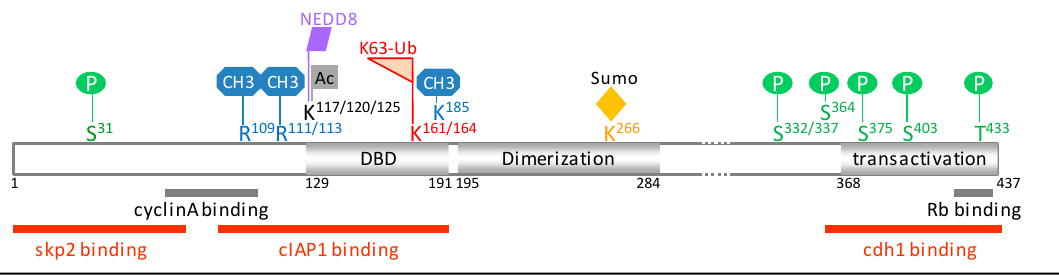
Figure 2. Schematic representation of E2F1 protein sequence (NP_005216.1). The regions interacting with cyclin A, Rb (retinoblastoma), and the E3-ubiquitine ligases skp2 (S-phase kinase-associated protein 2), cIAP1 (cellular inhibitor of apoptosis 1), and cdh1 are shown. Amino acid residues involved in post-translational modifications are indicated. E2F1 is subjected to several post-translation modifications in response to genotoxic stress, including phosphorylation on S 31 by the ataxia telangiectasia mutated/ataxia telangiestasia and Rad3-related (ATM/ATR) [37], on S 364 by checkpoint kinase 2 (chk2) [38], methylation on K 185 by Set7/9 [39,40], and on R 109 by the protein arginine N-methyltransferase 1 (PRMT1) [41], demethylation on R 111/113 [41], de-neddylation [42], and acetylation by the histone acetyl-transferase p300/CREB-binding protein-associated factor (P/CAF) on K 117/120/125 [43,44] and K63-ubiquitination on K 161/164 by cIAP1 [35]. The amino acid residues R 111/113 are targets of methylation by PRMT5 [41,45], K 117/120/125 of neddylation [46], K 266 of sumoylation [47], S 332/337 of phosphorylation by the cyclin-dependent kinase 1 (cdk1) [48], and S 403 /T 433 by the p38 mitogen-activated protein kinase (MAPK) [49]. DBD: DNA binding domain.